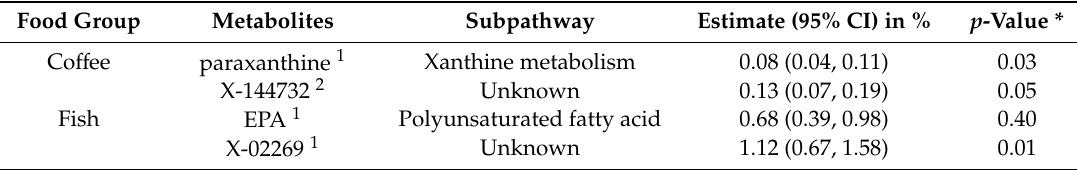
Table 4. Food-metabolite associations in the identification